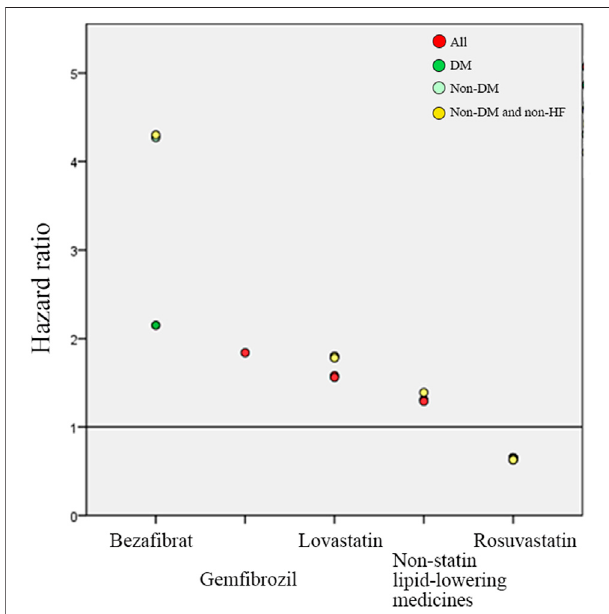
FIGURE 4 | Multivariable Cox hazard ratio regression outcomes oflipid- lowering medicines on predicting the risk of reHospIS. Only signi fi cant lipid- lowering medicines are presented. Atorvastatin users were served as the reference group, the horizontal line of value one. There are four hyperlipidemic patient subgroups marked in different colored circles. The red circle is all hyperlipidemic patients (All). The green circle is hyperlipidemic patients with diabetes (DM). The light green circle is non-DM hyperlipidemic patients. The yellow circle is non-DM and none-HF hyperlipidemic